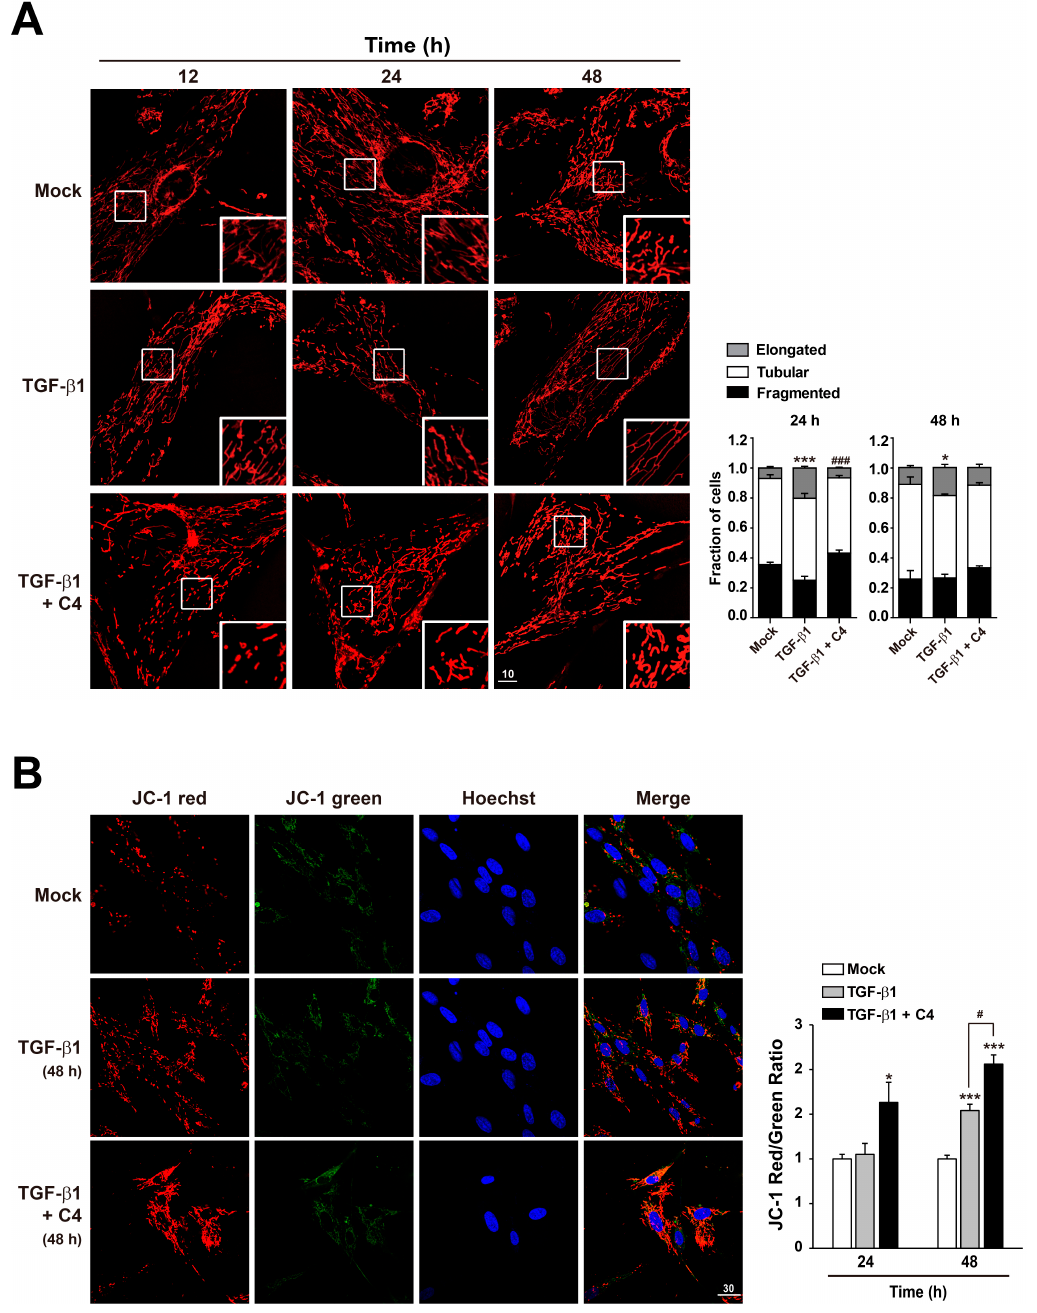
Figure 4. Effect of butyrate on mitochondrial morphology and function in TGF- β 1-treated pulmonary fibroblasts. ( A ) MRC5 cells were stained with Hoechst 33,258 and Mitotracker Red after treatment with TGF- β 1 (5 ng/mL) for the indicated times, with or without C4 (5 mM). Samples were analyzed by fluorescence microscopy. Scale bar denotes 10 µ m. Representative images are shown. Data are means ± SEM; * p < 0.05 and *** p < 0.01; Mock vs. TGF- β 1-treated cells, ### p < 0.001; TGF- β 1- treated cells vs. TGF- β 1 + C4-treated cells. ( B ) MRC5 cells were stained with Hoechst 33,258 and JC-1 after treatment with TGF- β 1 (5 ng/mL) for the indicated times, with or without C4 (5 mM). Samples were analyzed by fluorescence microscopy. Scale bar denotes 30 µ m. Representative images are shown. Mean fluorescence intensities (MFI) of JC-1 staining were measured with FV10-ASW image analysis software (Olympus). Data are means ± SEM; * p < 0.05 and *** p < 0.001; Mock vs. TGF- β 1-treated cells or TGF- β 1 + C4-treated cells. # p < 0.05; TGF- β 1-treated cells vs. TGF- β 1 + C4-treated